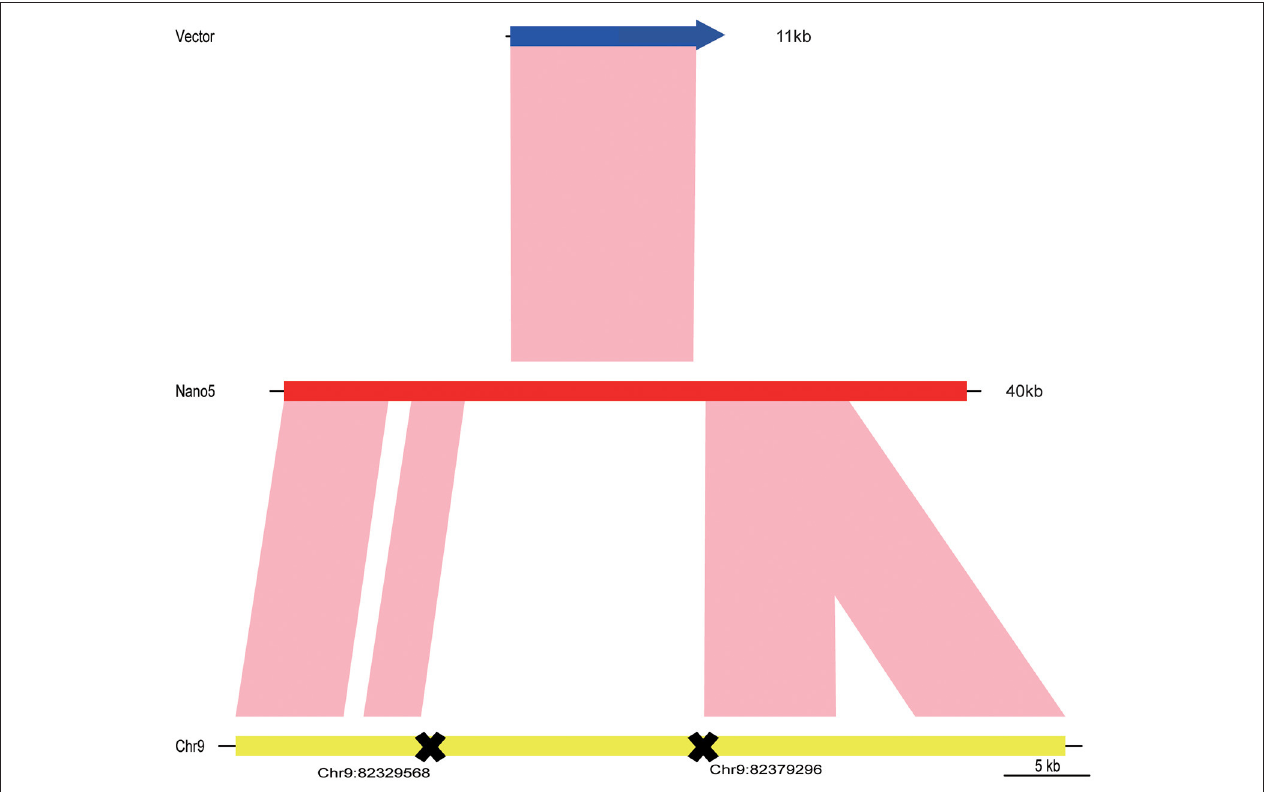
FIGURE 7 | The three sequences for the vector, nano5 read, and maize genome were compared and drawn using the R package “genoPlotR” (Guy et al.,